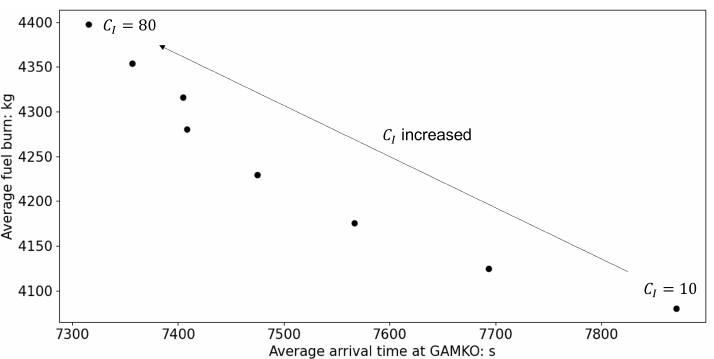
Figure 12. Trend of the average arrival time at GAMKO vs. the average fuel burn of the robust trajectories with C I = [ 10;80 ] kg/min. RTA is not imposed.